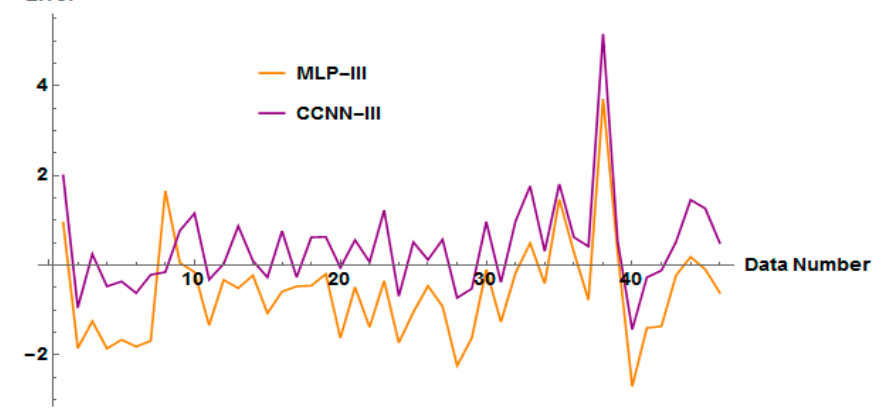
Figure 8. Error residual values for the standalone models for the testing phase.